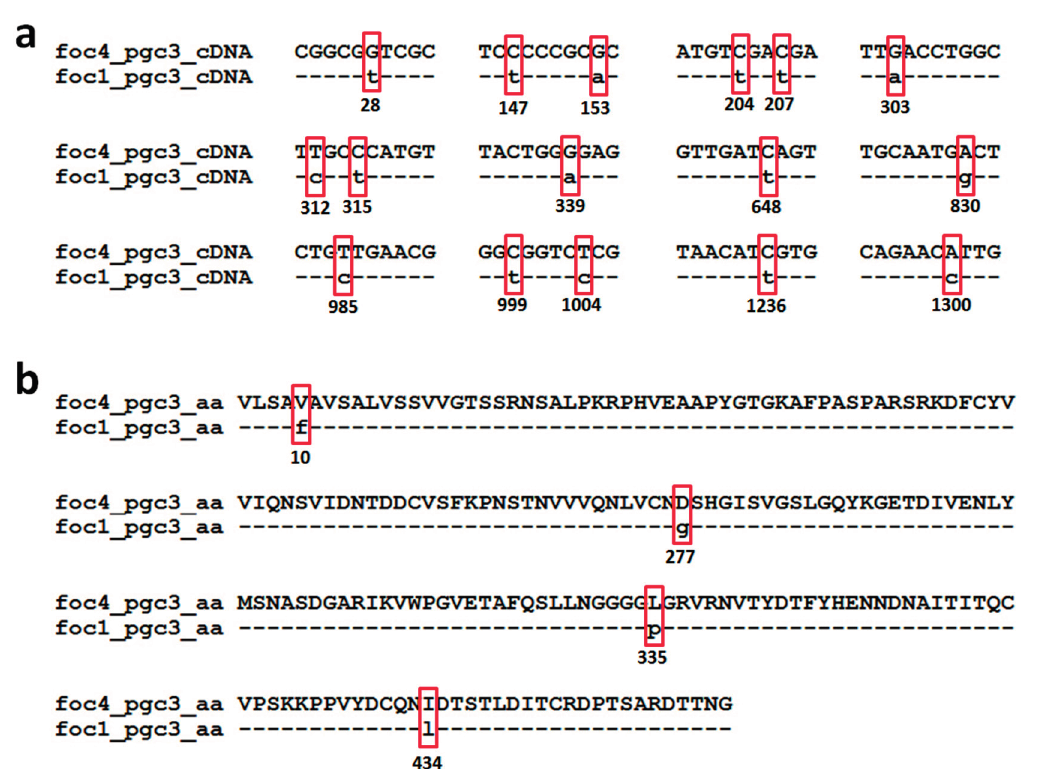
Figure 2. Pairwise sequence alignment of the nucleotide sequences (open reading frame, ORF) and predicted proteins of pgc3 from FOC1 and FOC4. ( a ) Alignment of ORF of pgc3 from FOC1 and FOC4; ( b ) alignment of predicted proteins of pgc3 from FOC1 and